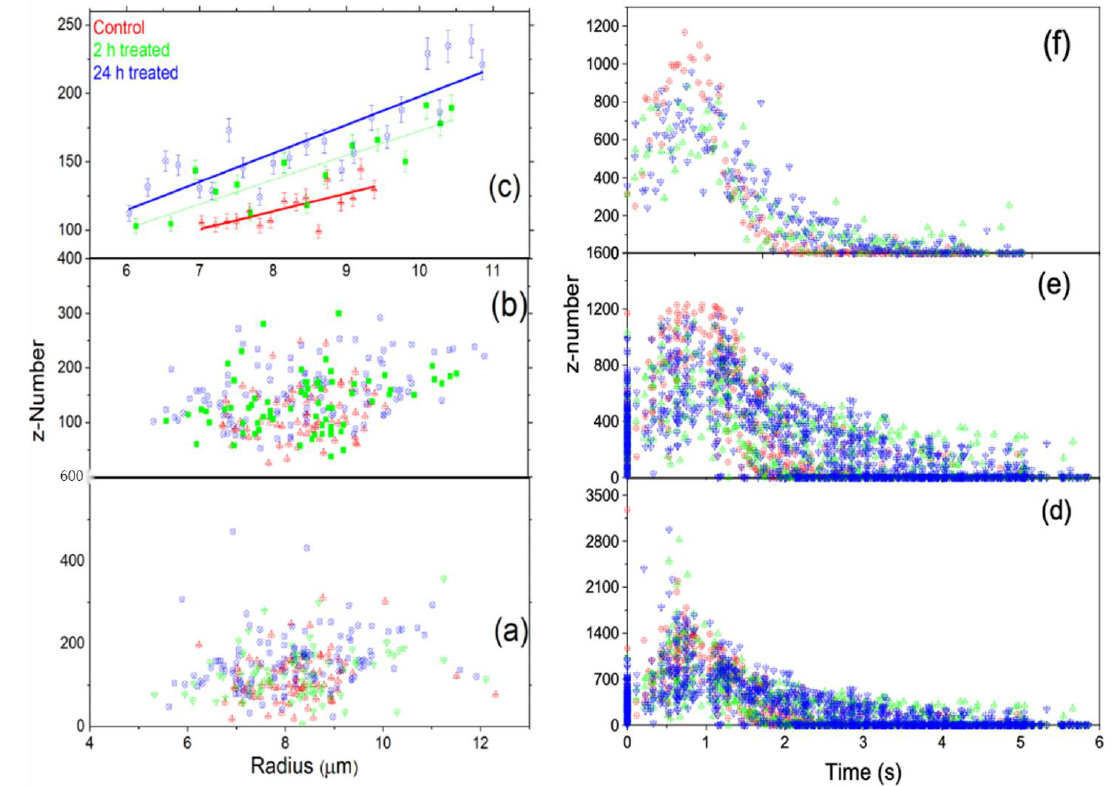
Figure 9. The data distribution of the whole untreated, 2 h-treated, and 24 h-treated data for the three groups. ( a,b ) show the behavior of the charge with radius. ( c ) The data is reduced further from ( b ) using Origin data manipulation reduction by grouping method, and linearly fitting. ( d – f ) show that charge decreases with time.